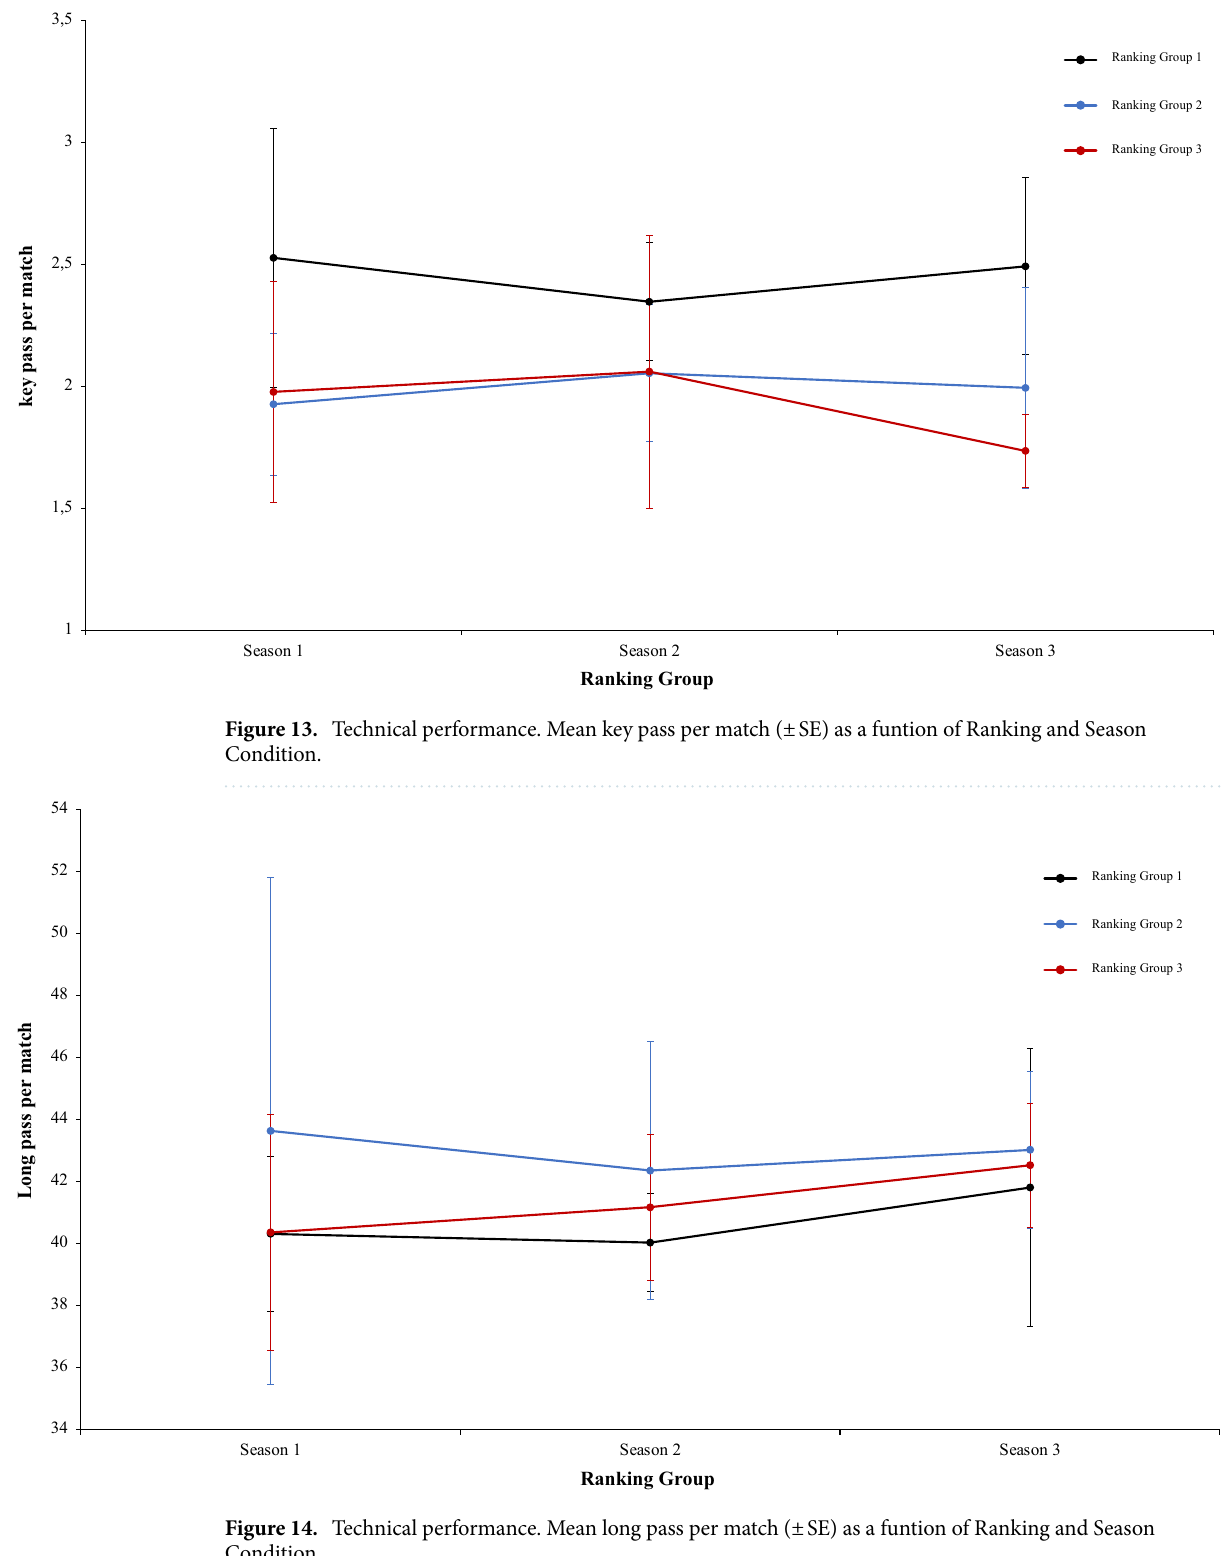
Figure 14. Technical performance. Mean long pass per match (± SE) as a funtion of Ranking and Season